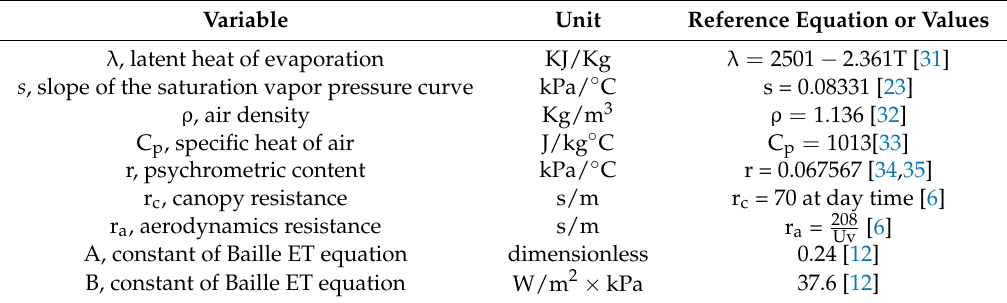
Table 1. Components of the evapotranspiration (ET) model.